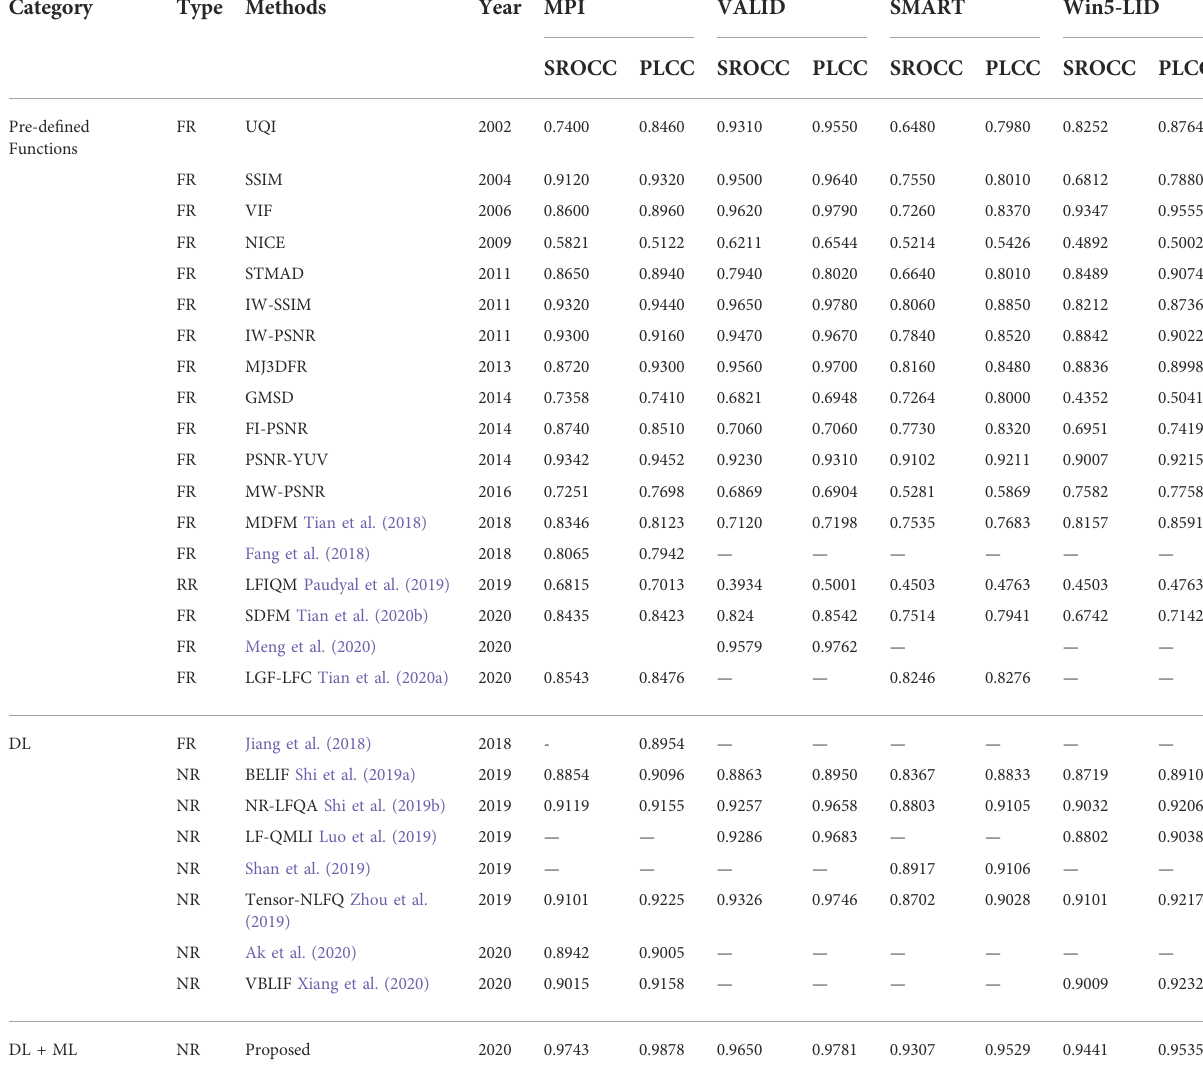
TABLE 3 SROCC and PLCC values obtained for state-of-the-art LF-IQA methods tested on VALID, SMART, MPI, and Win5-LID datasets.